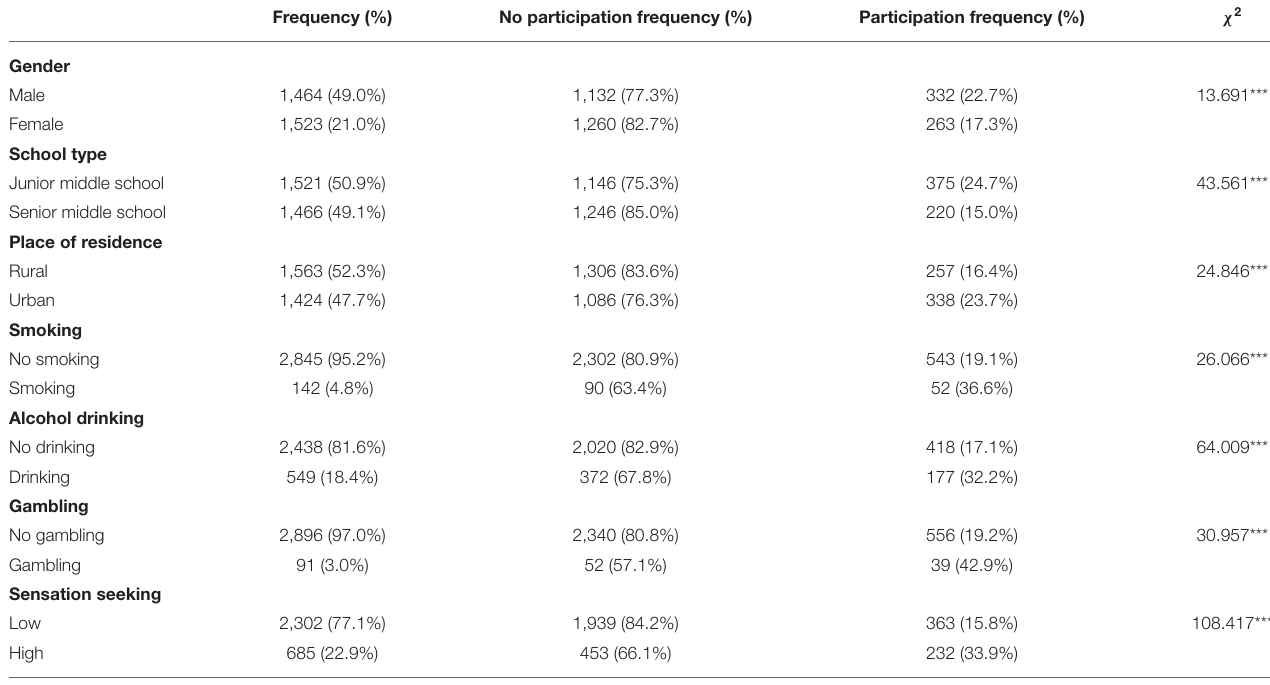
TABLE 2 | The difference in extreme sports participation rate according to the characteristics of participants.